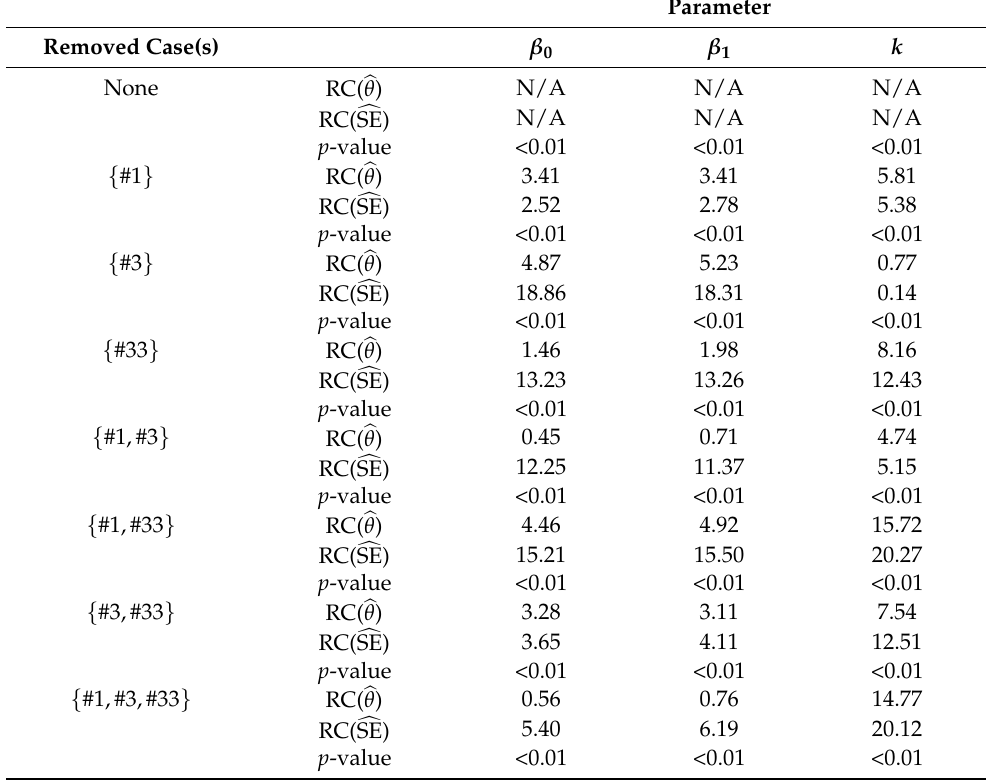
Table 12. RCs of maximum likelihood estimates and of the associated estimated SEs for the indicated cases, and respective p -values for the data of time to electrical breakdown of an insulating fluid and the Weibull quantile